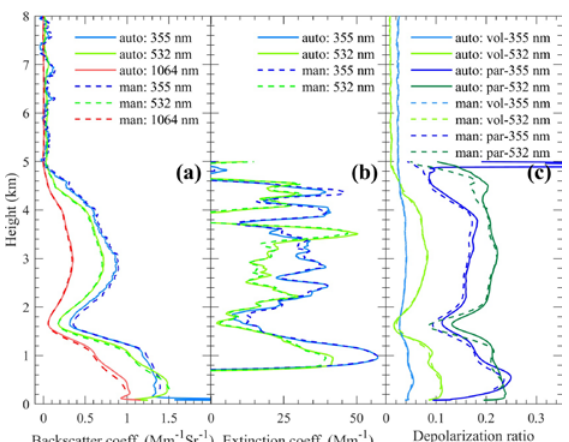
Figure 5. Lidar calibration results on 06 April 2017, at Limassol, Cyprus. (a) Aerosol backscatter coefficient at 532 nm with Raman method, averaged from 22:41 to 23:59 UTC, (b) lidar calibration constant profile.